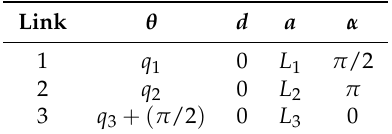
Table 3. Denavit–Hatenberg Parameters of the hexapod’s leg.